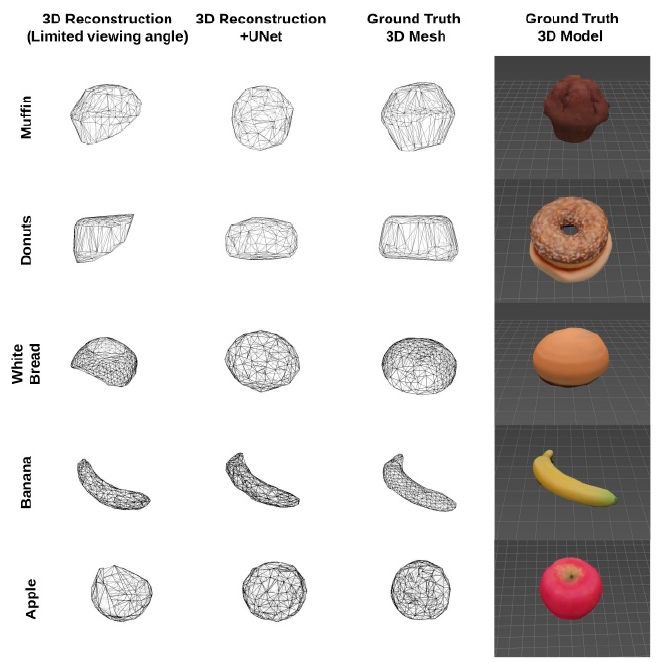
Figure 5. 3D reconstruction of various food models with deep learning view synthesis, Lo et al.